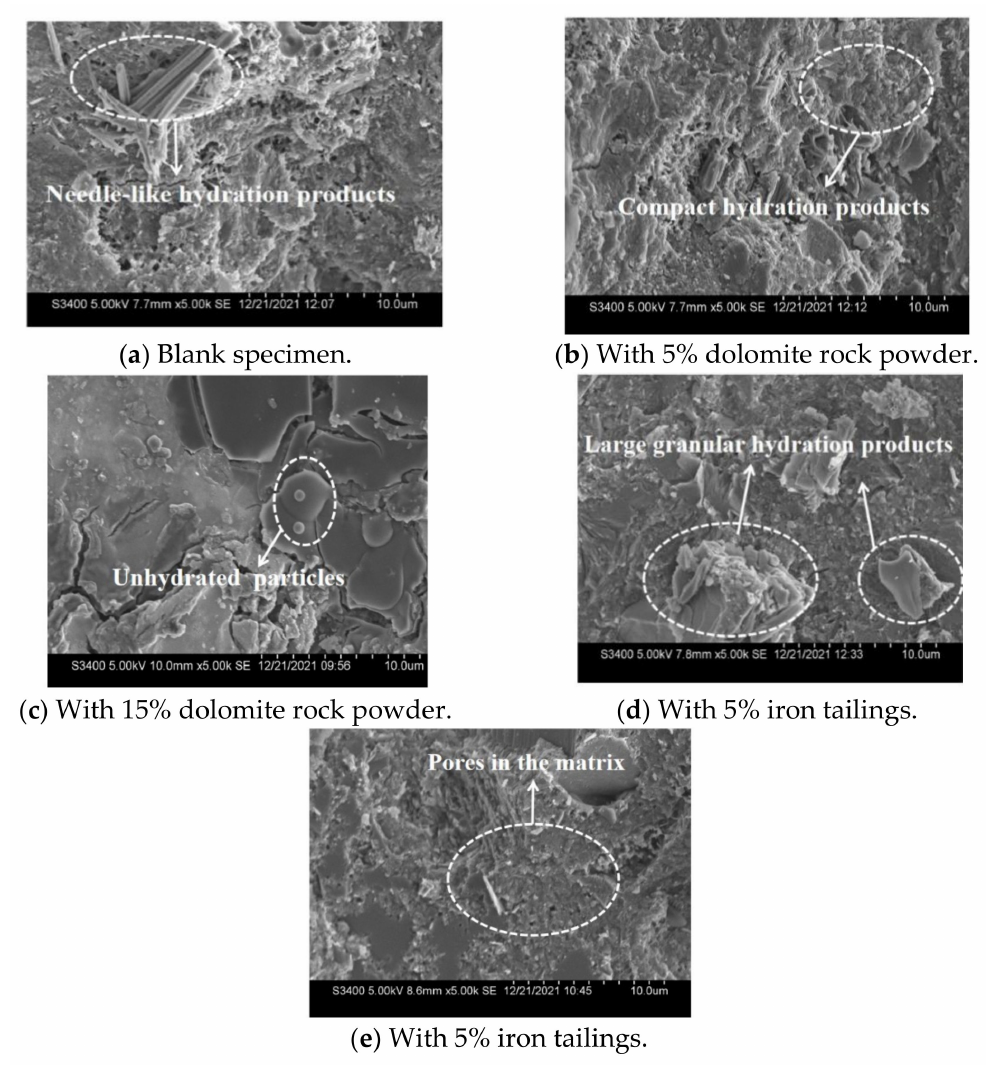
Figure 6. SEM microstructure photos of cement